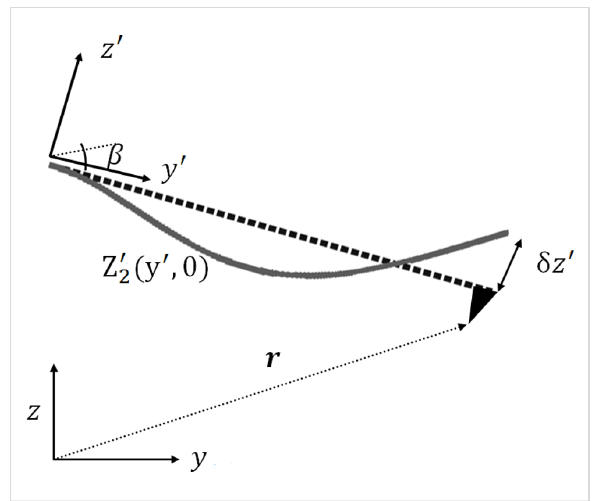
Figure 7: Second harmonic deflection relative to the cantilever at its rest position. The free edge deflection of the cantilever is δ z '. All the other amplitude values along the cantilever are calculated relative to this deflection.